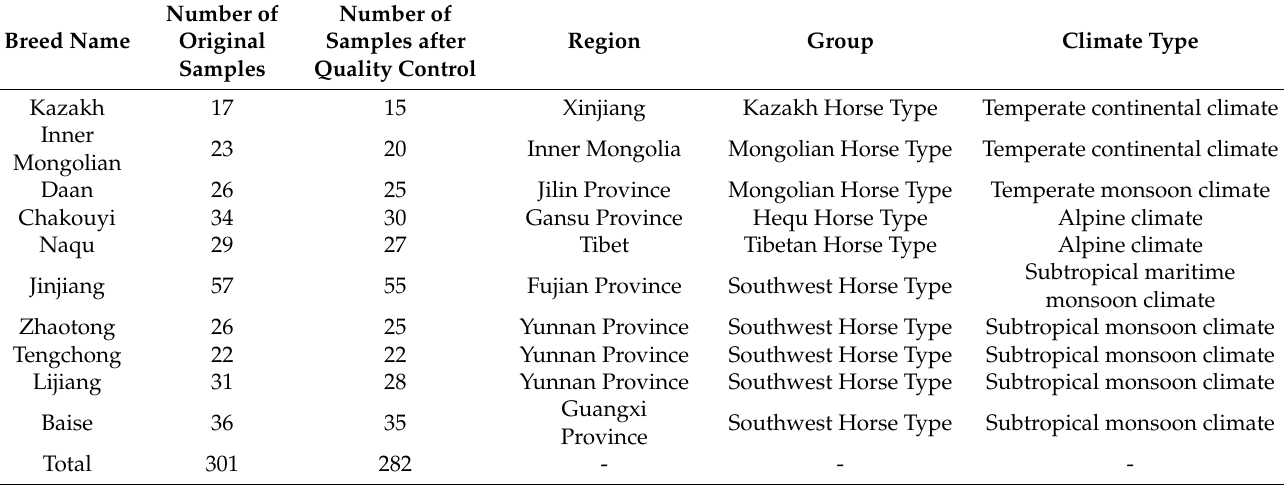
Table 1. Sample information of ten Chinese indigenous horse